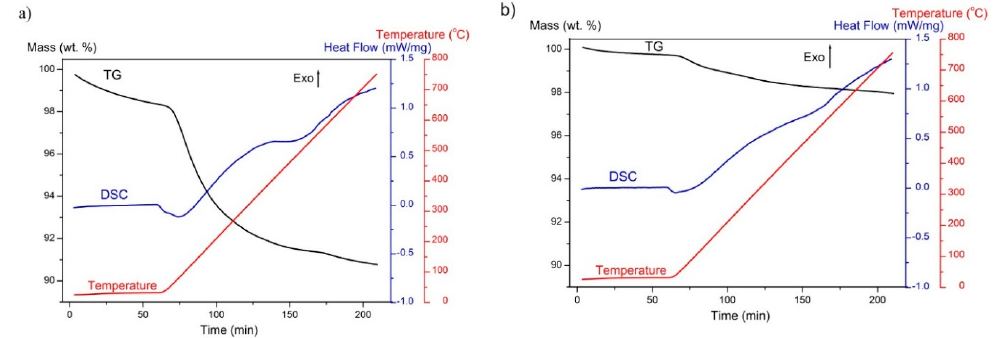
Figure 9. Thermogravimetry (TG) and calorimetry (DSC) curves of ( a ) GoHAP-1 (10 nm) and ( b ) GoHAP-6 (40 nm) soaked up to 800 °C. The temperature change as a function of time is also presented.